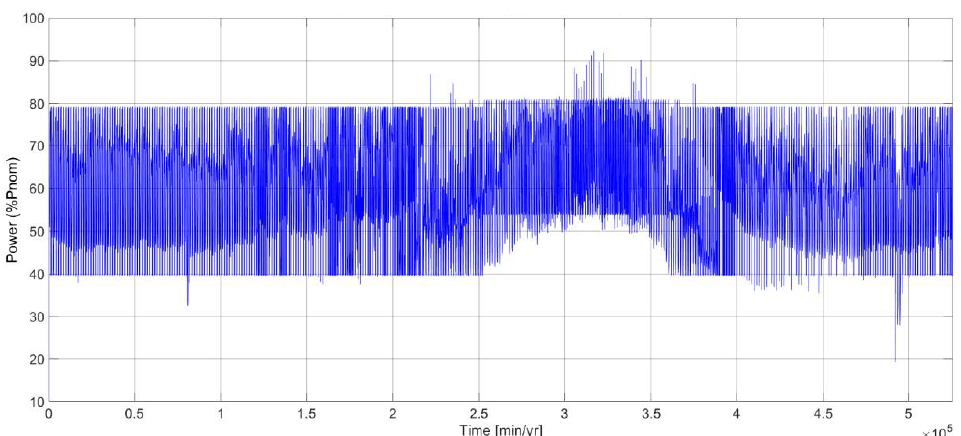
Figure 18. Working point of generators: configuration with